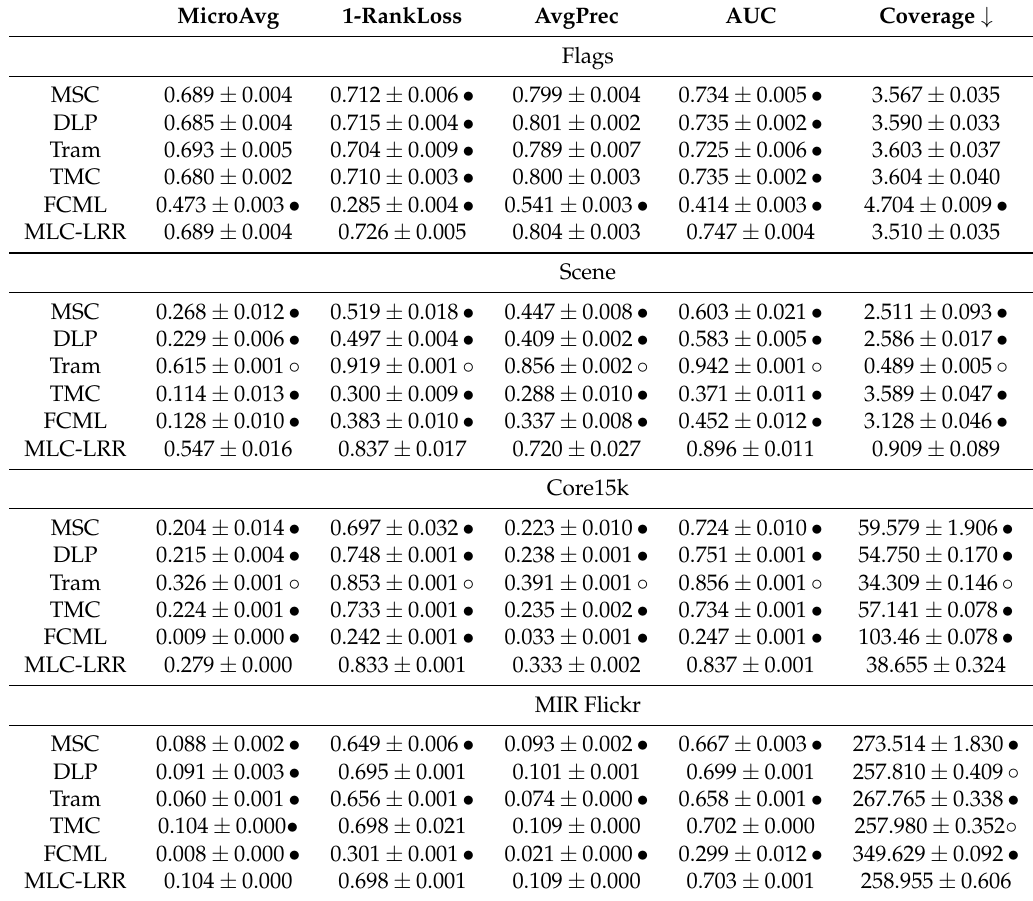
Table 4. Experimental results (mean ± std) on Flags, Scene, Core15k, MIR Flickr and ESPGame with 30% labeled images. • / ◦ indicates whether MLC-LRR is statistically (pairwise t -test at 95% significance level) superior/inferior to the comparing methods under a particular evaluation